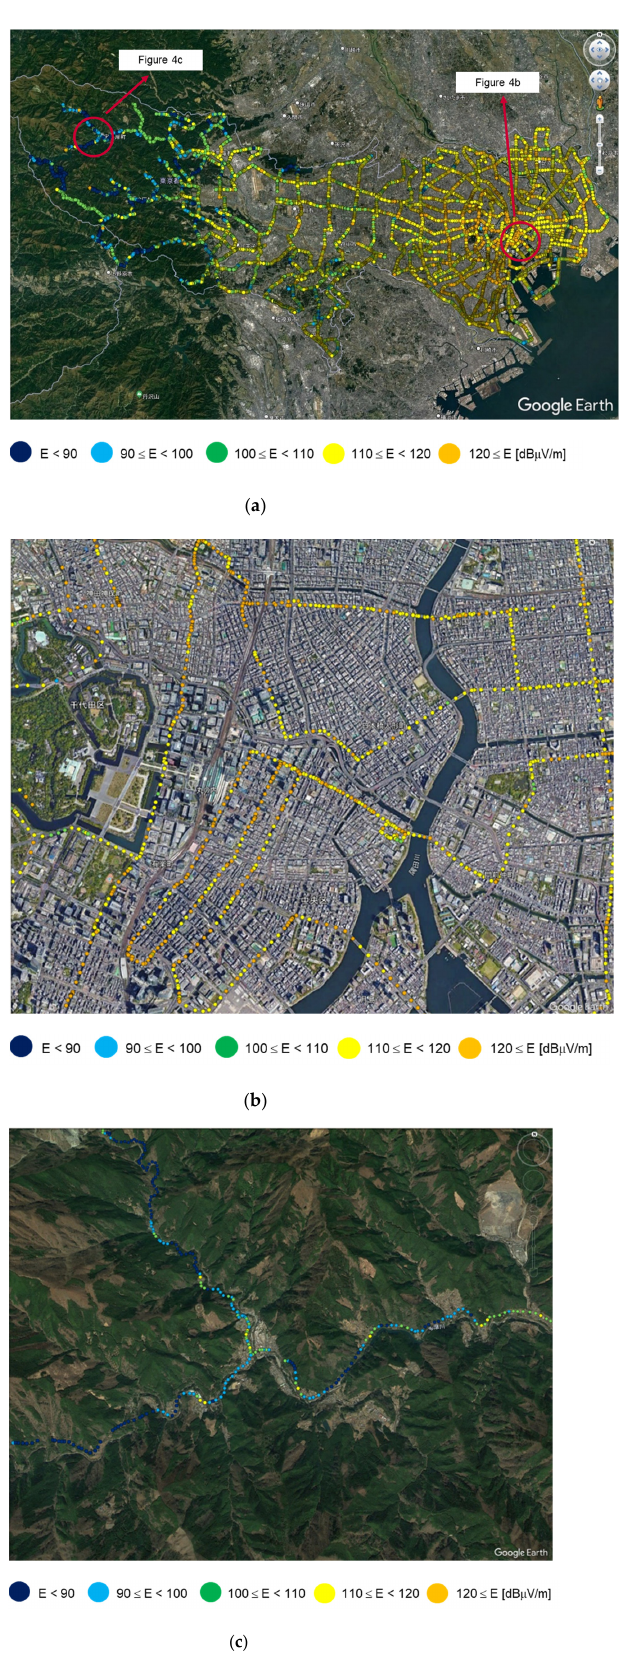
Figure 4. Examples of measurement results in Tokyo. ( a ) Whole area of Tokyo; ( b ) around Nihon- bashi; ( c ) Okutama area.